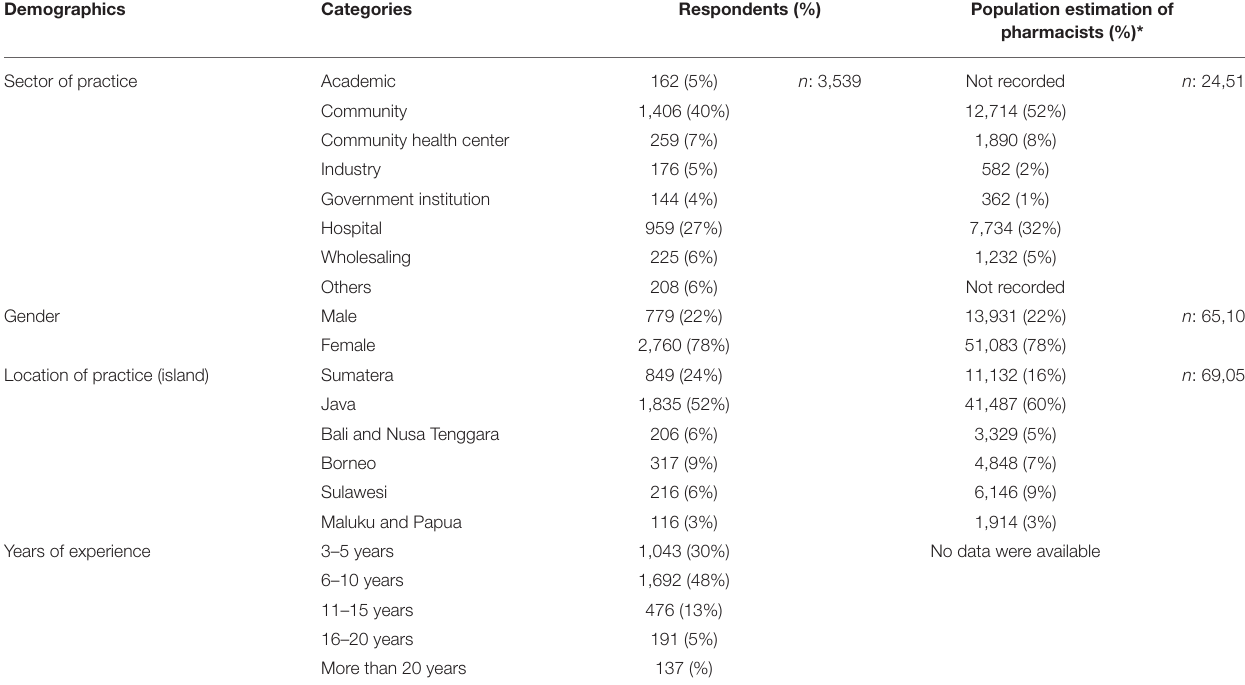
TABLE 2 | The demographics of participants included in the